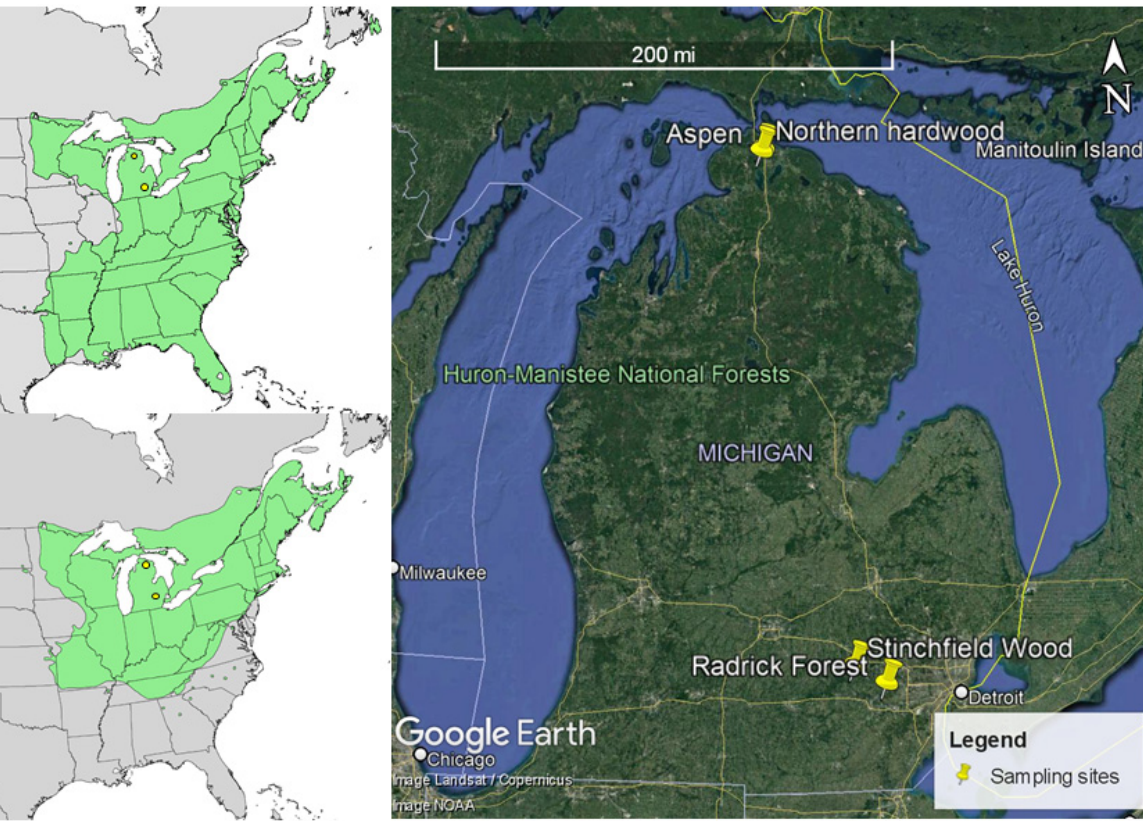
Figure 1. Distributional range of Acer rubrum L. ( left top ) and Acer saccharum Marshall ( left bottom ) and locations of study sites at two latitudes in Lower peninsula, Michigan ( Right ). (Map retrieved from https://www.usgs.gov/centers/geosciences-and-environmental-change-science-center, ac- cessed on 10 December 2021 and Google Earth, accessed on 3 March 2022).